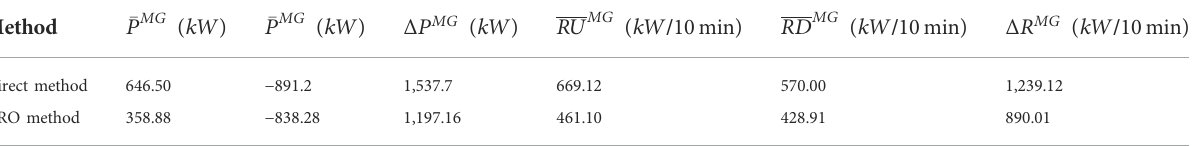
TABLE 3 Results of MG-FPs from different